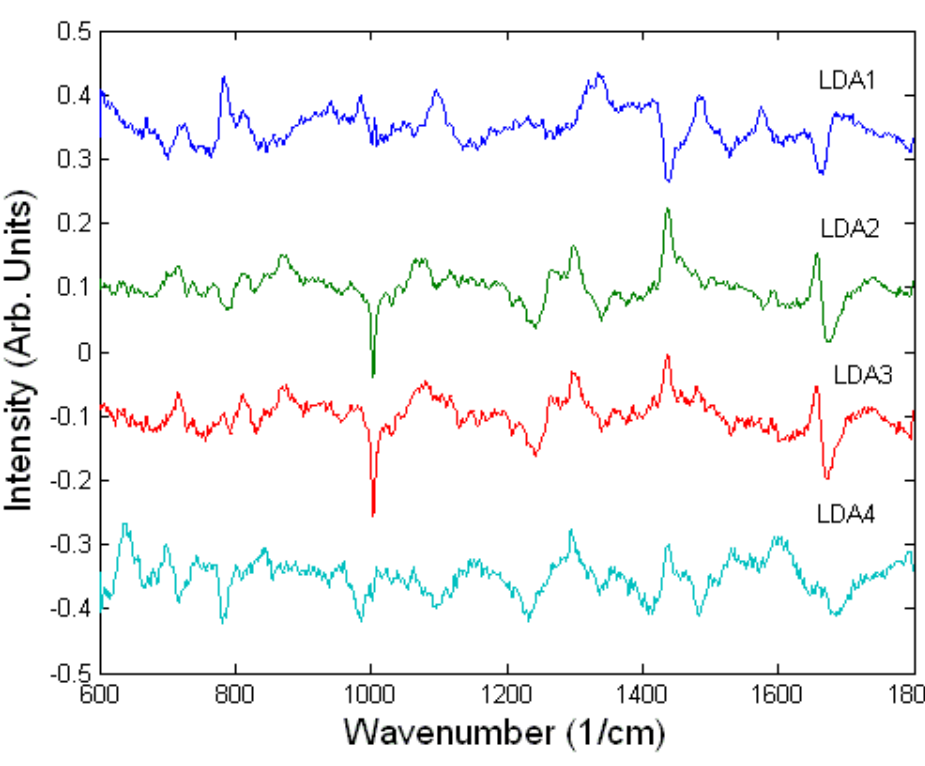
Figure 6 . LDA loadings for the model used to discriminate between the toxicology of ricin and sulphur mustard on A549